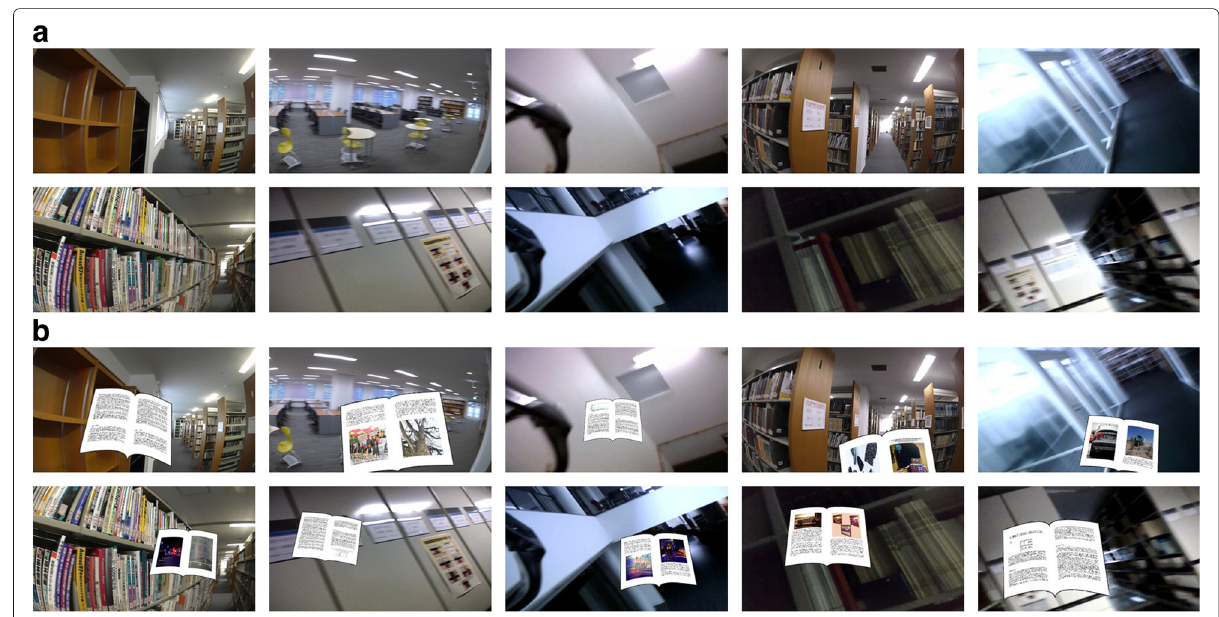
Fig. 11 Synthetic training samples with domain-specific background. a “Others” class. b “Reading”